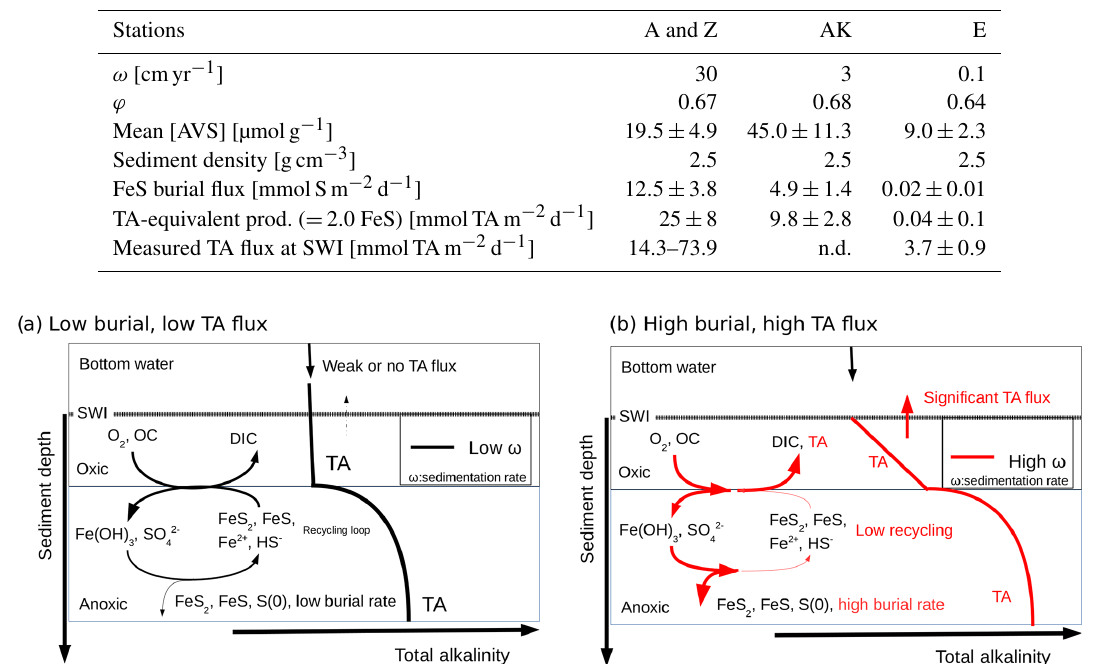
Figure 8. Conceptual model for visualizing the link between the burial of iron sulfide minerals and benthic alkalinity fluxes in the case of low sedimentation and OC flux (black) and high sedimentation rates and OC flux (red). The total alkalinity (TA) produced under anaerobic conditions at depth diffuses upwards towards the aerobic sediment layer where it is consumed during reoxidation of Fe 2 + and (cid:54) H 2 S by dissolved oxygen (black). If the precipitation of sulfide minerals is significant, the reduced iron and sulfide metabolites produced during anaerobic respiration are not reoxidized by dissolved oxygen, and the TA produced is able to reach the bottom waters (red). The intensity of the alkalinity flux into the bottom waters is indicated by the thickness of the arrow at the